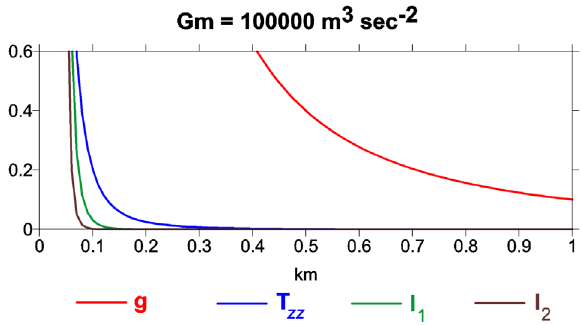
Figure 2. An example of decrease in the values of the aspects of the disturbing geopotential with increasing distance (depth) from their source. On the x axis there are kilometres, on the y axis there is an arbitrary quantity (for a simple intercomparison). This is an il- lustrative case for a mass point, representing a density anomaly, with a random value of GM